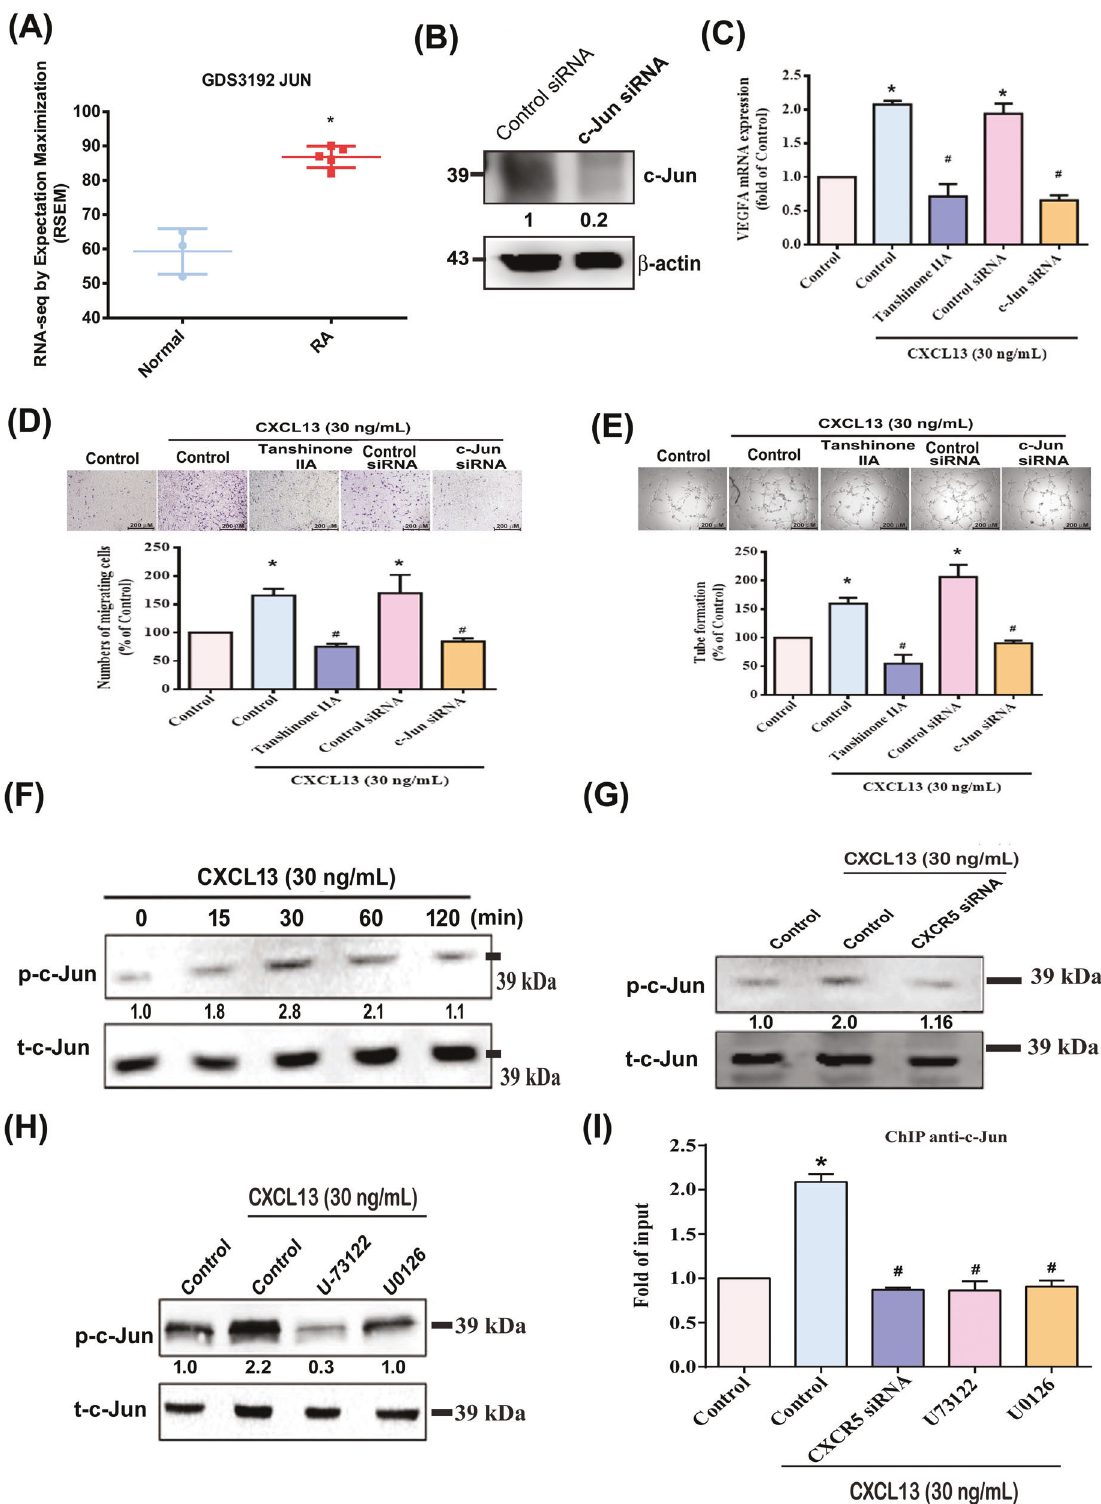
homing and angiogenesis through the PLC, MEK, and AP-1 signaling pathways via binding to the CXCR5 receptor on the EPC surface. Inhibiting CXCL13 antagonized EPC in fi ltration and angiogenesis, inhibiting RA progression (Fig. 8). The evidence supports the targeting of CXCL13 in RA treatment